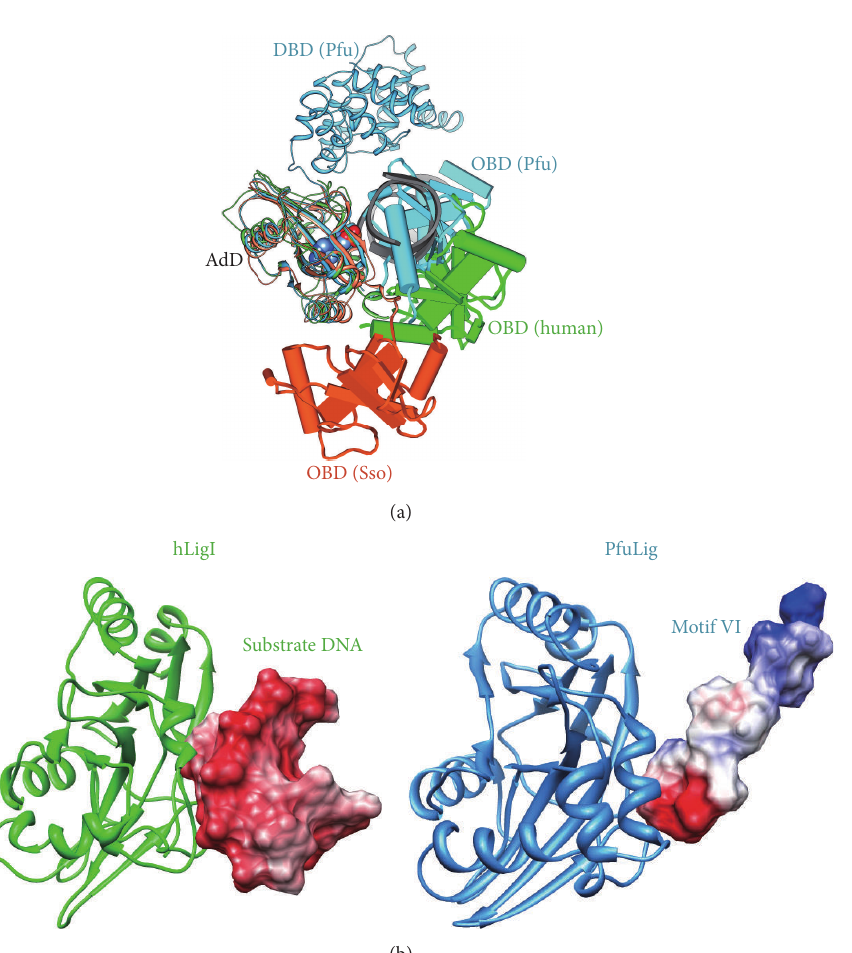
Figure 10: Superimposed ribbon diagrams. (a) Ribbon diagrams of PfuLig (2CFM, blue), hLigI (1X9N, green), and SsoLig (2HIV, orange), in which the AdD from each ligase were maximally overlapped with each other. The DBD from hLigI and SsoLig were omitted, for clarity. The arrangements of the OBD relative to the AdD in each ligase are apparently different from each other. Notably, the OBD from PfuLig is closely bound to AdD and is replaced by the bound-DNA substrate (grey) in hLigI. (b) Superimposed diagrams of adenylation domains from PfuLig and hLigI, flanked by surface representations of motif VI (PfuLig) and the upstream region of the substrate DNA (hLigI), in which the electrostatic distributions (positive charge, blue; negative charge, red) are mapped onto the molecular surfaces. Since the electrostatic distributions on the surfaces nearby the AdD of motif VI and the DNA are both negatively charged, the replacement of motif VI with DNA may easily